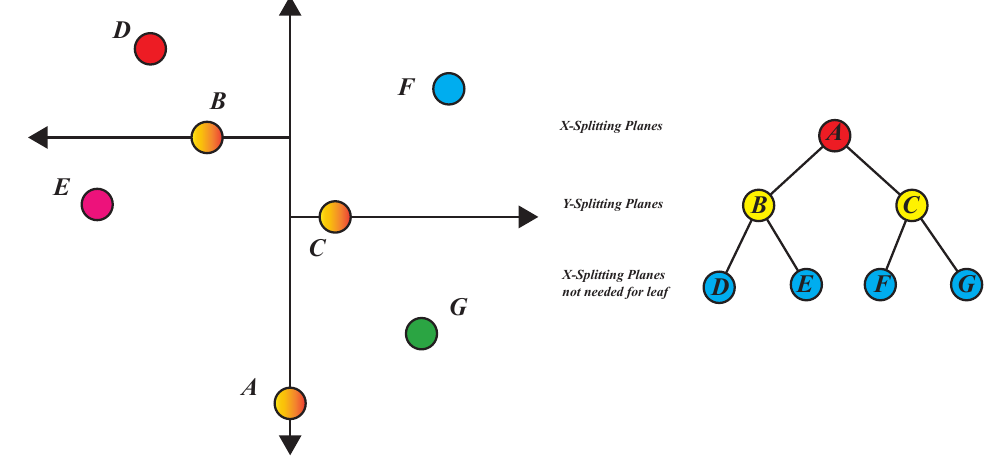
Figure 5. The working principle of k-d